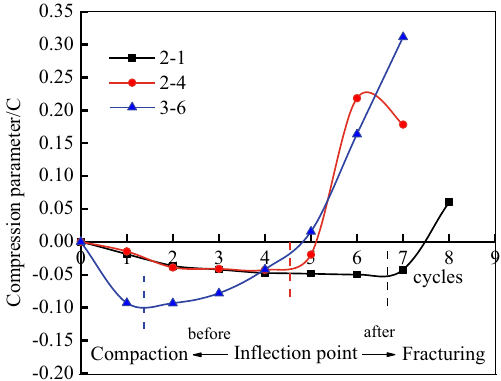
Fig. 11 The evolution of the compression parameter C